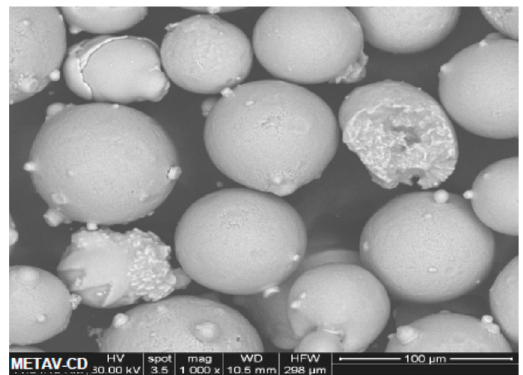
Figure 5. SEM of the surface morphology revealing attached satellite particles adhered and the phenomenon of the coalesced particles.